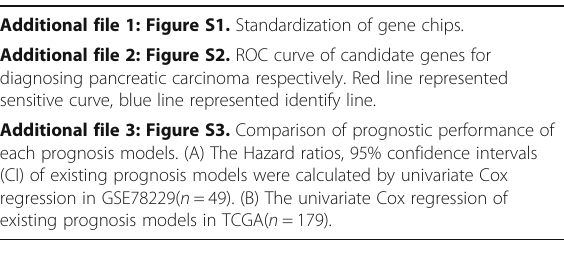
Additional file 1: Figure S1. Standardization of gene chips. Additional file 2: Figure S2. ROC curve of candidate genes for diagnosing pancreatic carcinoma respectively. Red line represented sensitive curve, blue line represented identify